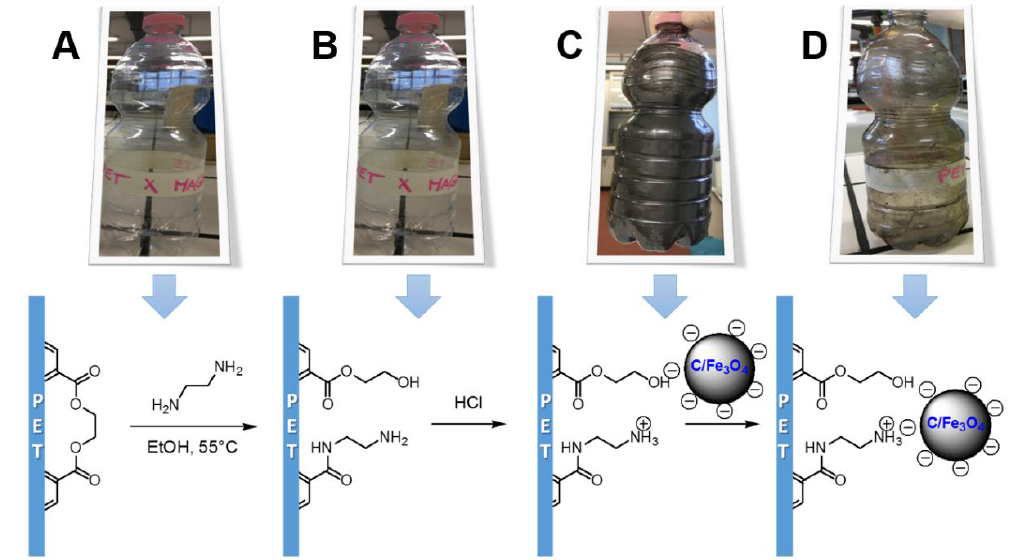
Figure 5. Schematic representation of the development of the purification device prototype. Pictures taken from each step are shown (see also Figure S5): ( A , B ) poly(ethylene terephthalate) (PET) bottle before and after aminolysis, ( C ) adhesion of magnetite-carbon composite particles (before rinsing), ( D ) the final prototype.